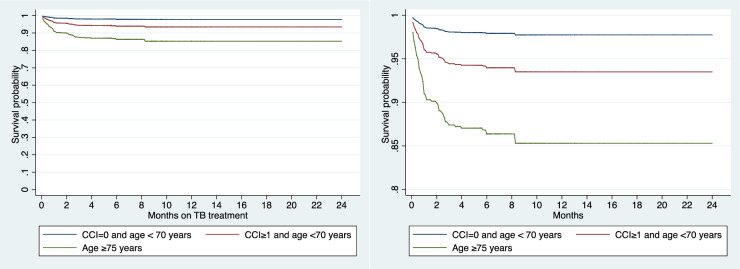
A and B1 Survival curves of three risk groups among tuberculosis patients alive at diagnosis. 1: Magnified view of the survival curves CCI: Charlson comorbidity index.